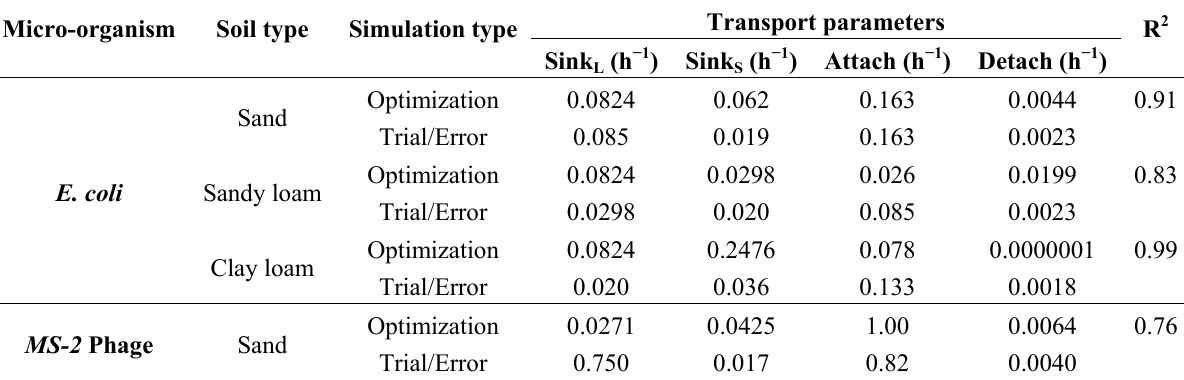
Table 5. E. coli and virus transport parameters derived from HYDRUS 2D/3D [23]. Non-detects of virus tracer in sandy loam and clay soils prevented modeling of these